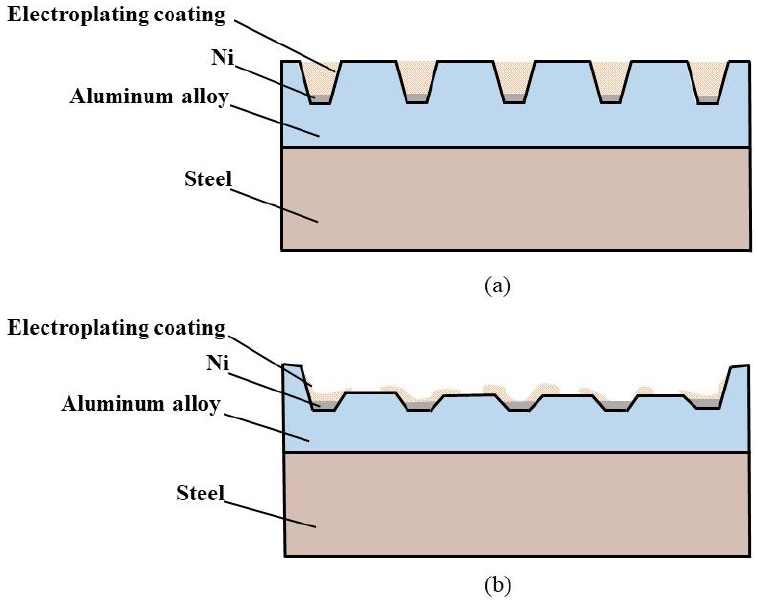
Figure 9. Wear mechanism of the sliding bearing. ( a ) Original ( b ) and after wear.